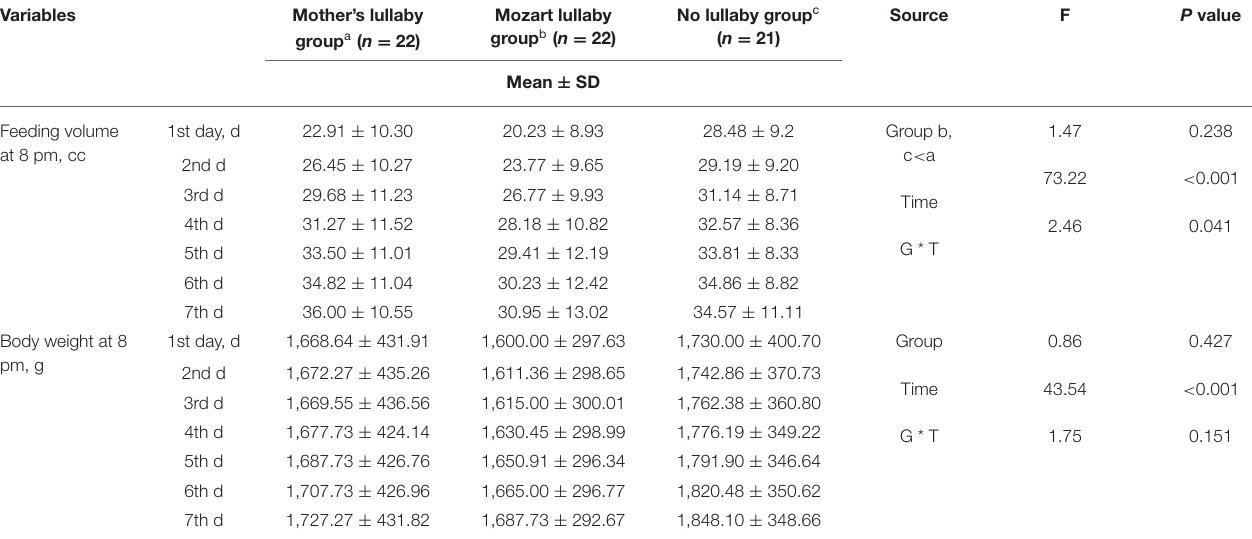
Mozart lullaby No lullaby group c Source F P value group b ( n = 22) ( n = 21) group a ( n = 22)